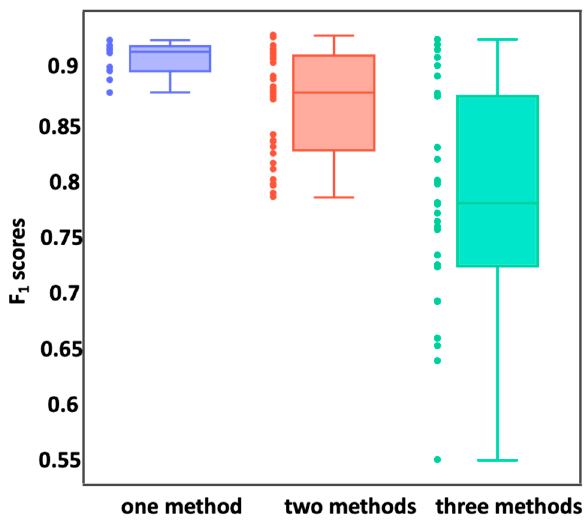
Figure 1. Boxplot of F1 scores. The blue dots represent the F1 scores of the models containing the reduced features obtained using a single method. The red dots represent the F1 scores of the models containing the reduced features obtained using the combination of two methods. The green dots represent the F1 scores of the model containing the reduced features obtained using the combination of three methods.